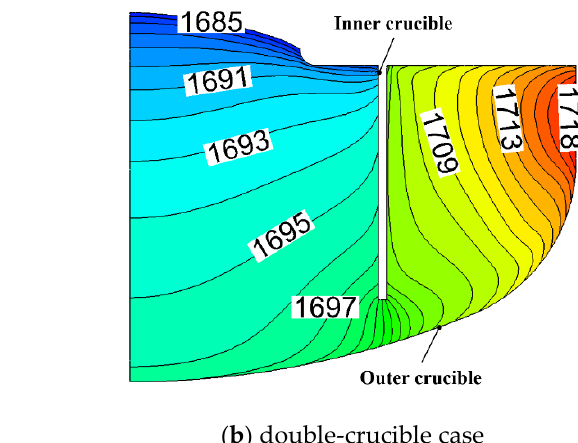
Table 1. The dimensions of the continuous-feeding Czochralski method (CCZ) furnace.